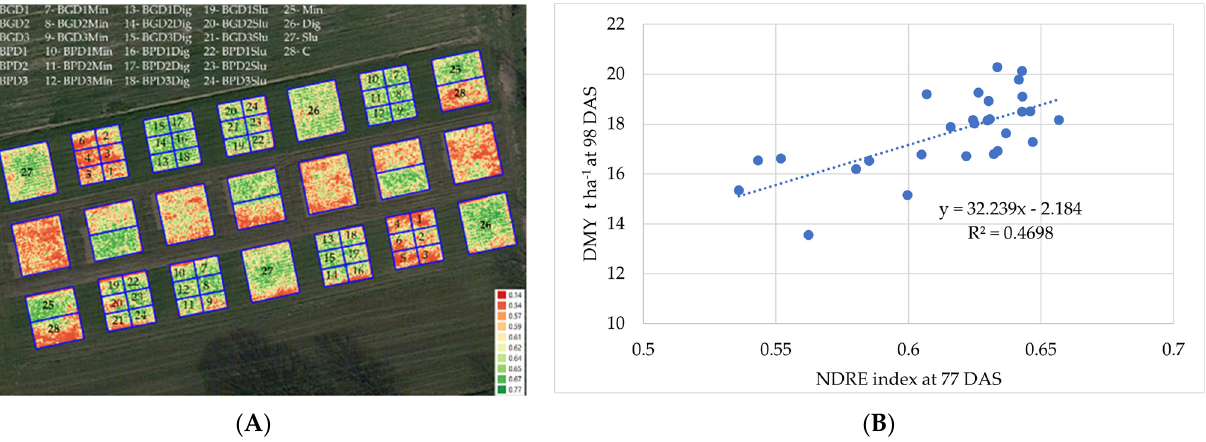
Figure 1. ( A ) NDRE index estimation obtained in 2019 at 77 days after sowing (DAS) by UAV- mounted multispectral camera monitoring. ( B ) Plot-averaged correlation between NDRE at 77 DAS and DMY at 98 DAS.